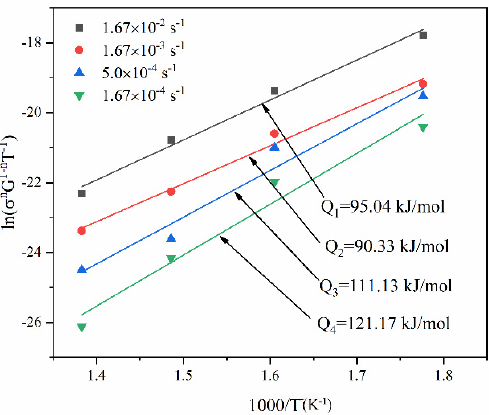
(cid:0) (cid:1) − σ n G 1 − n T − 1 1/ T in GAZ211 alloy at different strain